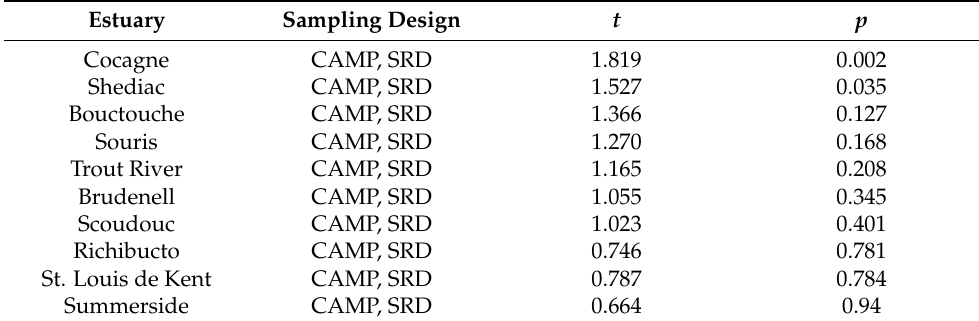
Table 3. Permutational-MANOVA (PERMANOVA) pair-wise test results for factor Sampling Design within factor Estuary for nekton data collected from the Community Aquatic Monitoring Program (CAMP) and Stratified Random Design (SRD) stations.